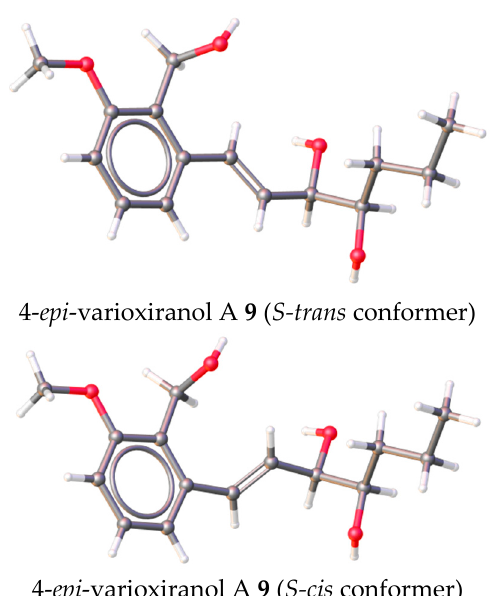
Figure 2. A ball-and-stick view of crystal structures 4 and 9 .